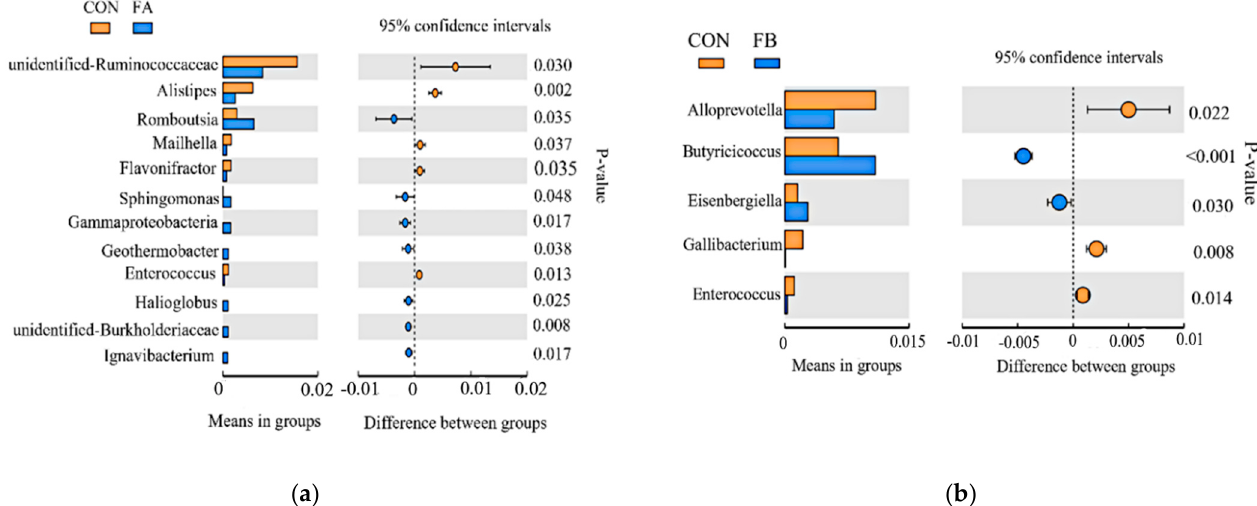
Figure 2. The relative abundance of bacterial genera in the cecal microbiota of layers in different groups 1 . ( a ) T -test of cecal contents at the genus level between CON and FA; ( b ) T-test of cecal contents at the genus level between CON and FB. CON, control group; FA, basal diet with 6% FF produced by B. subtilis , Lactobacillus , Yeast ; FB, basal diet with 6% FF produced by C. butyricum , L. salivarius .